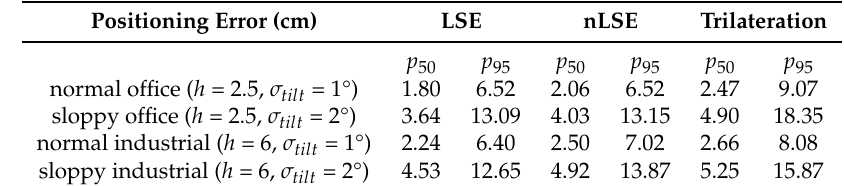
Table 2. Median and maximal positioning errors for the three localization approaches, for four typical LED deployments.